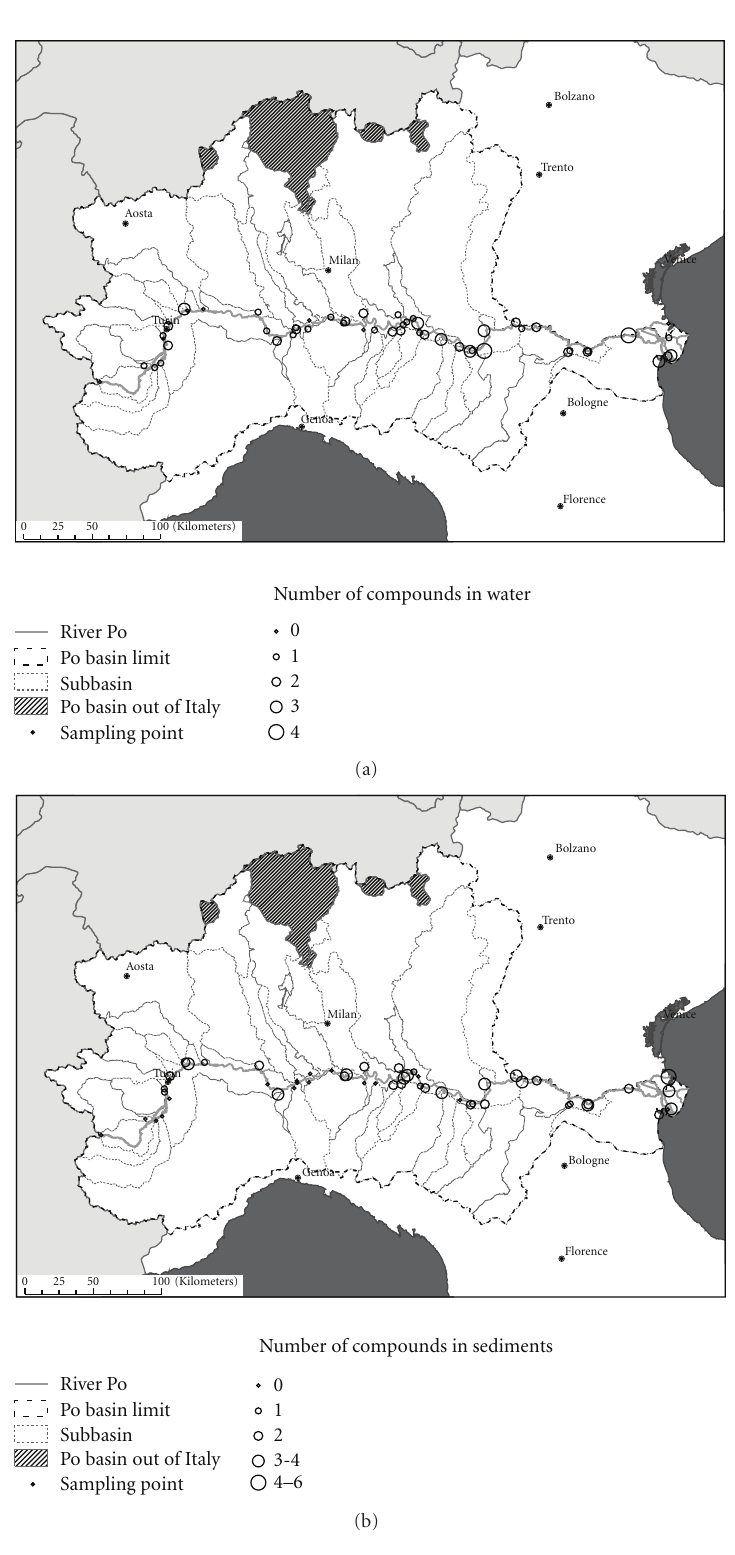
Figure 3: Number of compounds detected in water (a) and sediment (b) samples collected in river Po basin and its